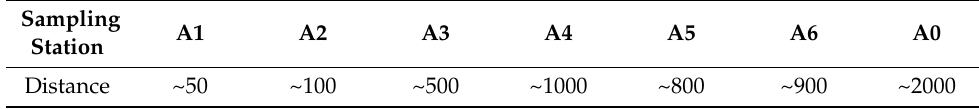
Table 1. Distance from biofouling sampling stations to drainage outlet